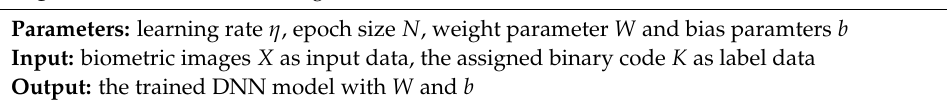
Algorithm 1 Process of training network in our DNN model